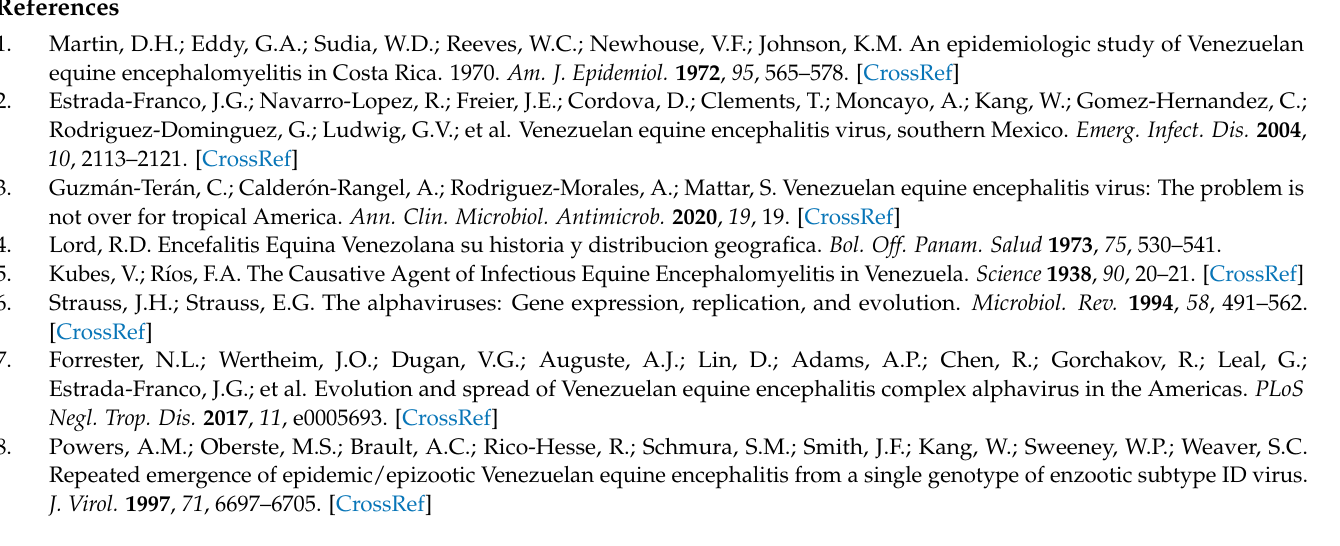
isolation country. Figure S3: Predicted interactions in the E1 and E2